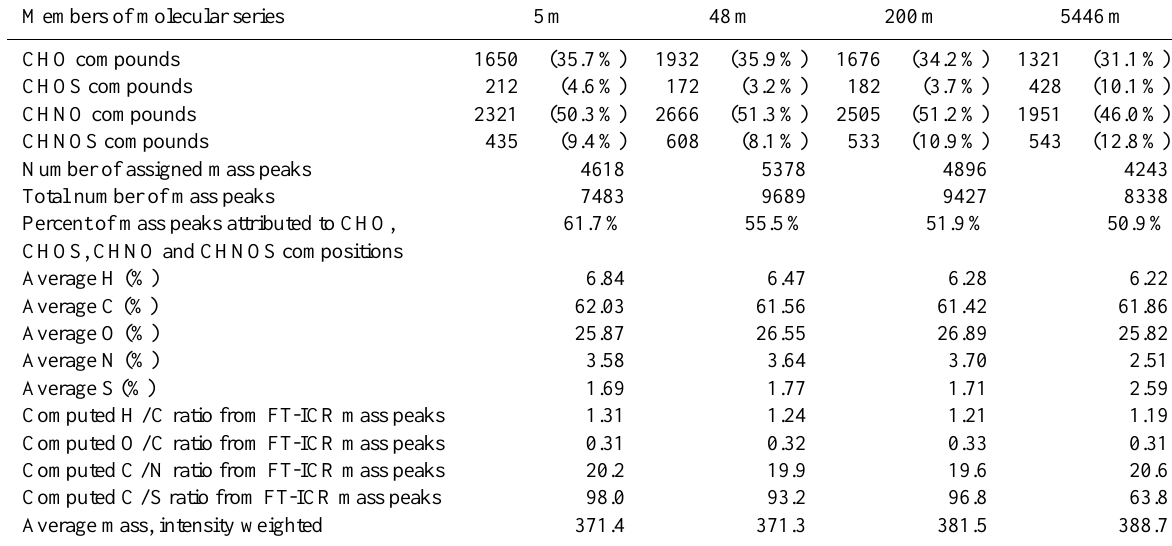
Table 5. Counts of mass peaks as computed from positive electrospray 12TFTICR mass spectra for singly charged ions with nitrogen rule check and 500ppb